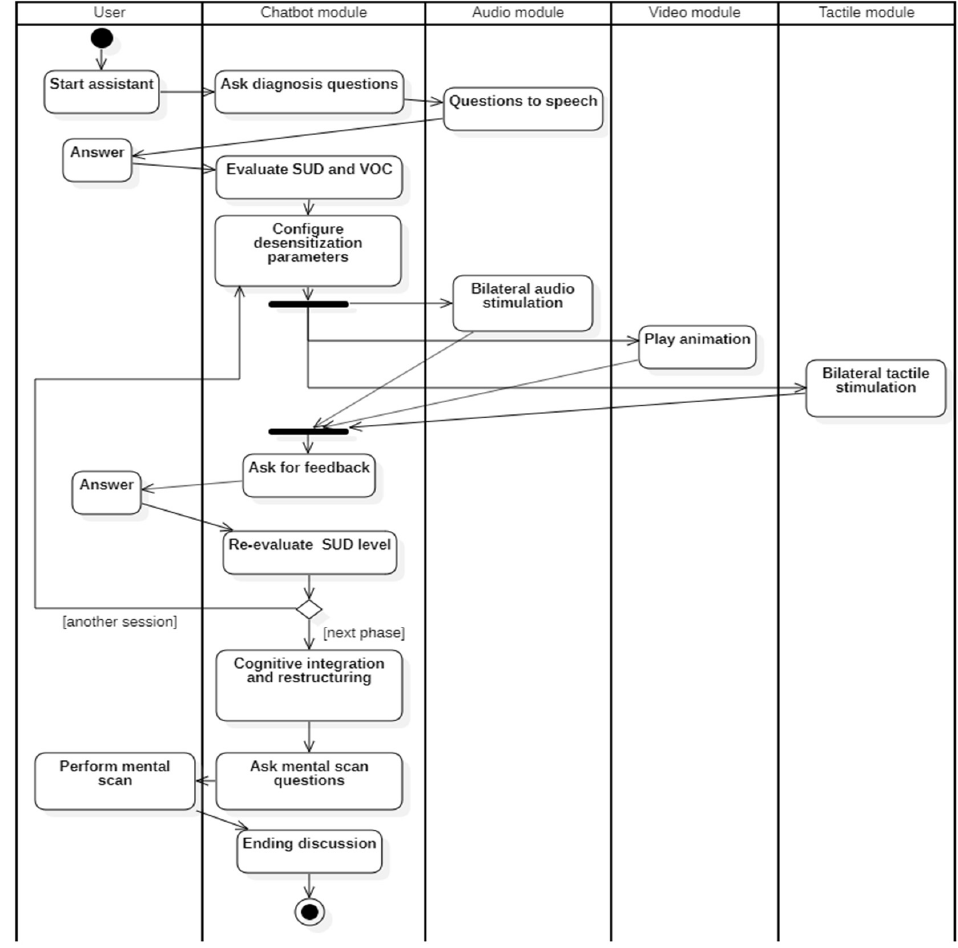
Figure 3. The overall flow of the system.